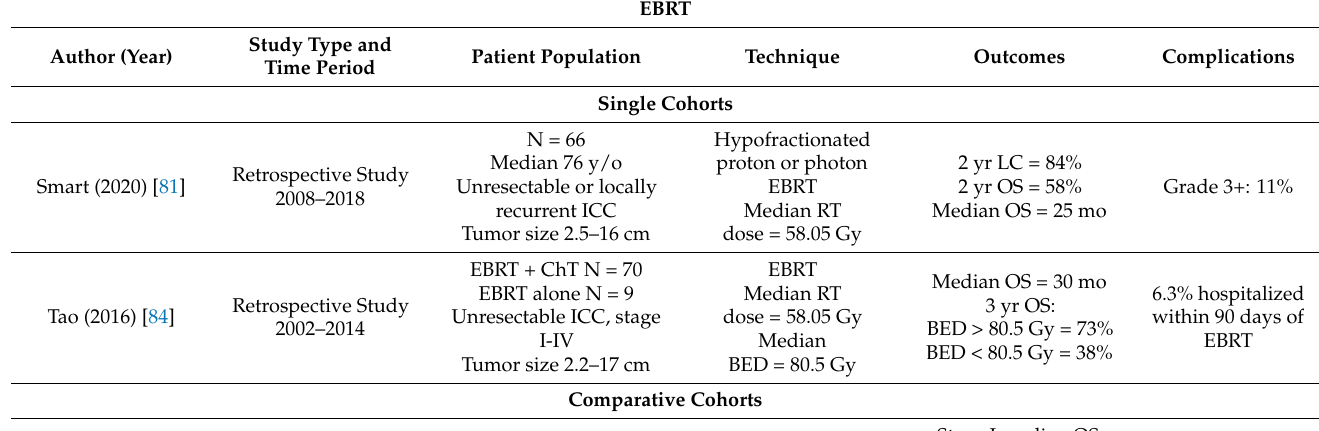
Table 5. Studies examining external body radiotherapy (EBRT) for intrahepatic cholangiocarcinoma.